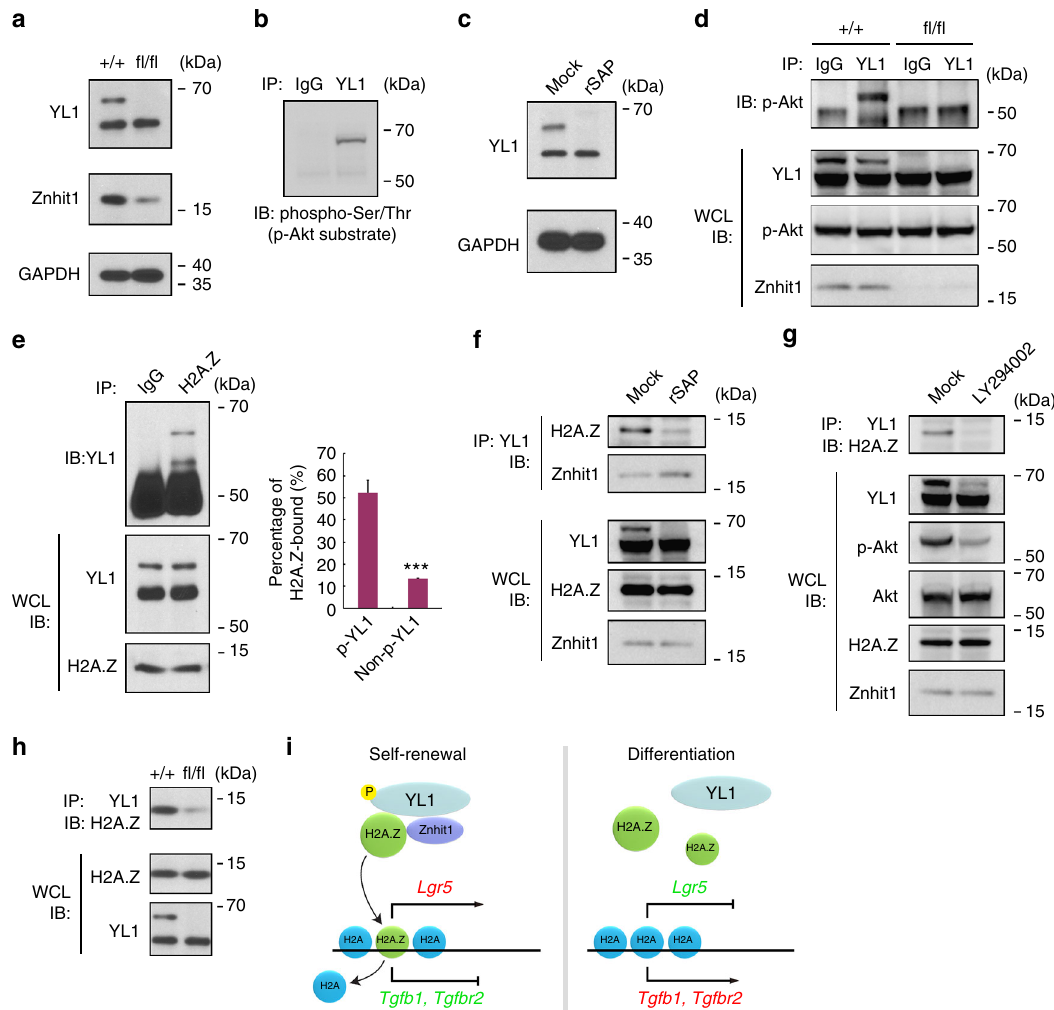
Fig. 5 Znhit1 mediates H2A.Z incorporation by enhancing the interaction between H2A.Z and YL1. a Eight-week-old Znhit1 + / + ; Olfm4-IRES-eGFPCreERT2 ( + / + ) and Znhit1 fl / fl ; Olfm4-IRES-eGFPCreERT2 ( fl / fl ) mice were daily injected with tamoxifen for 3 days followed by 4-day waiting period, then intestinal crypts were isolated for immunoblotting with the indicated antibodies. GAPDH served as a loading control. b Intestinal crypt (wild-type) were harvested for anti-YL1 immunoprecipitation then anti-phospho-Ser/Thr (p-Akt substrate) immunoblotting. c Intestinal crypt (wild-type) lysis was treated with rSAP for dephosphorylation then subjected to immunoblotting with the indicated antibodies. d Intestinal crypts were harvested from Znhit1 + / + ; Olfm4-IRES- eGFPCreERT2 ( + / + ) and Znhit1 fl / fl ; Olfm4-IRES-eGFPCreERT2 ( fl / fl ) mice following tamoxifen treatment for anti-YL1 immunoprecipitation then anti-p-Akt immunoblotting. WCL IB: whole cell lysis immunoblotting. e Intestinal crypts (wild-type) were harvested for anti-H2A.Z immunoprecipitation then anti-YL1 immunoblotting. Percentage of H2A.Z-bound phospho-YL1 (p-YL1) and non-phospho-YL1 (non-p-YL1) was quantitated. The statistical data represent mean ± s.d. ( n = 3 mice). Student ’ s t -test: *** P < 0.001. f Intestinal crypt (wild-type) lysis treated with rSAP were subjected to anti-YL1 immunoprecipitation then immunoblotting with the indicated antibodies. g Cultured organoids (wild-type) were treated with 25 μ M LY294002 for 12 h then harvested for anti-YL1 immunoprecipitation followed by immunoblotting. h Intestinal crypts were harvested from Znhit1 + / + ; Olfm4-IRES-eGFPCreERT2 ( + / + ) and Znhit1 fl / fl ; Olfm4-IRES-eGFPCreERT2 ( fl / fl ) mice following tamoxifen treatment for anti-YL1 immunoprecipitation then anti-H2A.Z immunoblotting. i Working model of how Znhit1-mediated H2A.Z incorporation regulates the transcription of Lgr5 + ISC fate